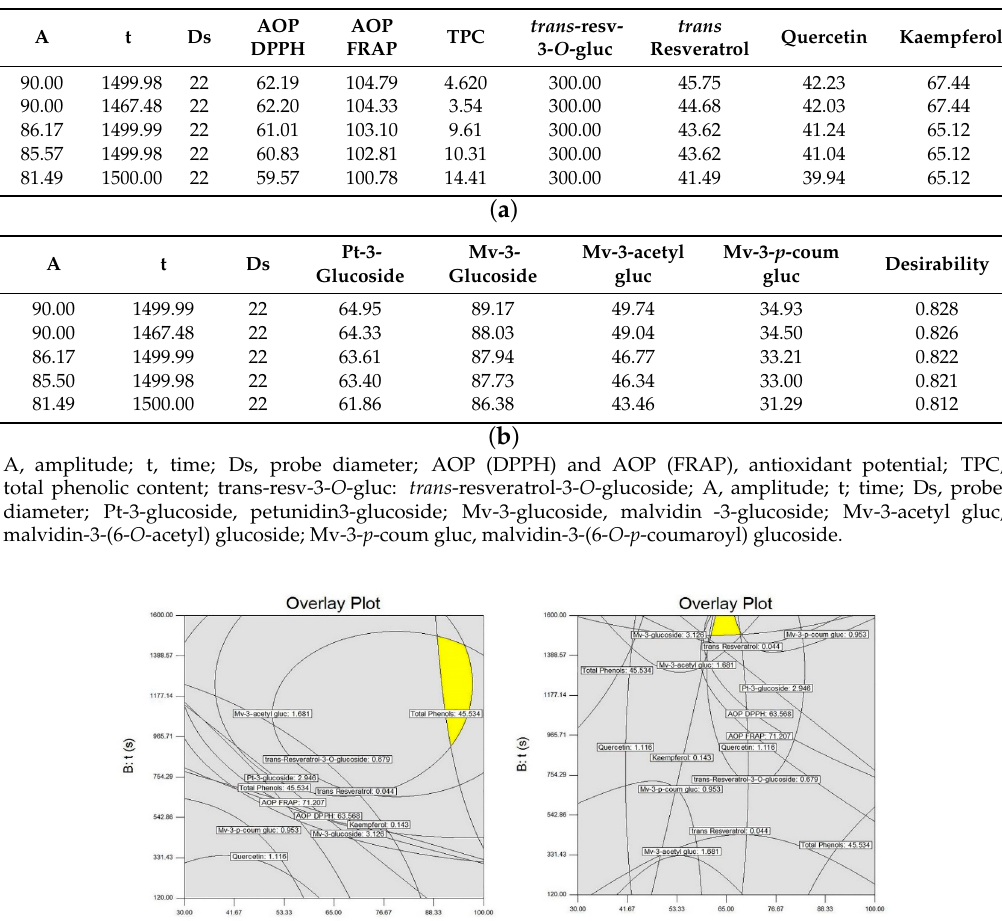
Figure 7. Optimal conditions of the ultrasound-assisted extraction of polyphenolic compounds from the wine lees of the Vranac variety which most significantly affect the AOP of the extracts using the ultrasonic probe with a diameter of 22 mm ( a ) and using the ultrasonic probe with a diameter of 40 mm ( b ). The obtained results regarding AOP are in accordance with other authors [45,73], who also confirmed an increase of AOP in wine lees extracts obtained with non-thermal technologies compared to the CE. The obtained results regarding TPC are also in accordance with other authors [45,73]. They also confirmed an increase of TPC in wine lees extracts obtained with use of non-thermal technologies compared to the CE. Results show that trans -resveratrol glucoside was dominant in the extracts of wine lees from the Merlot while trans -resveratrol content is 20-fold lower. In comparison to the wine lees of the Merlot, trans -resveratrol glucoside (t-Res-3- O -glc) was not found in the wine